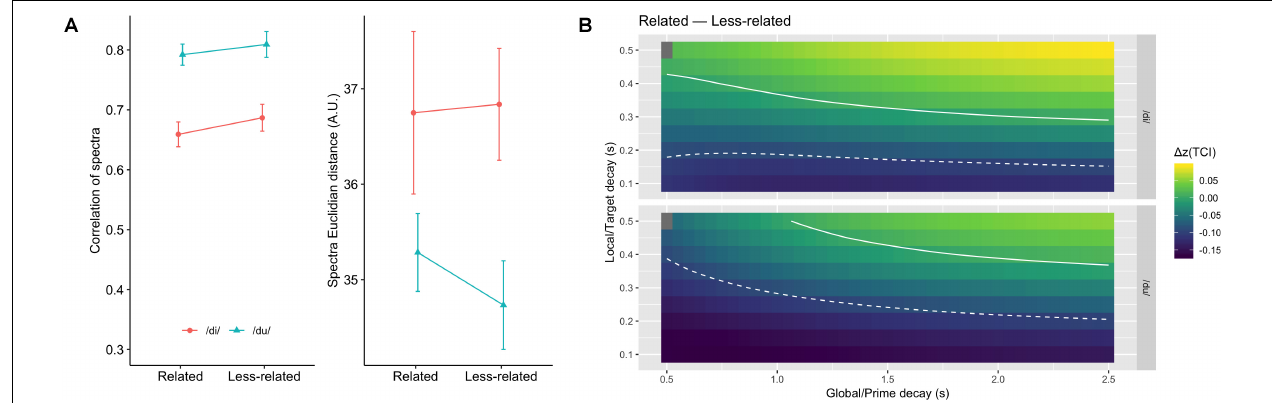
FIGURE 3 | Same as Figure 2 for the CI model. (A) Average spectral correlation (left) and Euclidian distance (right) for the related and less-related conditions, and for the two target syllables. Higher correlations, and smaller Euclidian distances, are compatible with more sensory priming. (B) Difference in Fisher transformed tonal contextuality index between related and less-related conditions, as a function of syllable, and global and local decays. The solid line represents the value 0.0 where the two types of context have the same TCI. The dashed lines represent the critical limit beyond which differences can be considered significant.